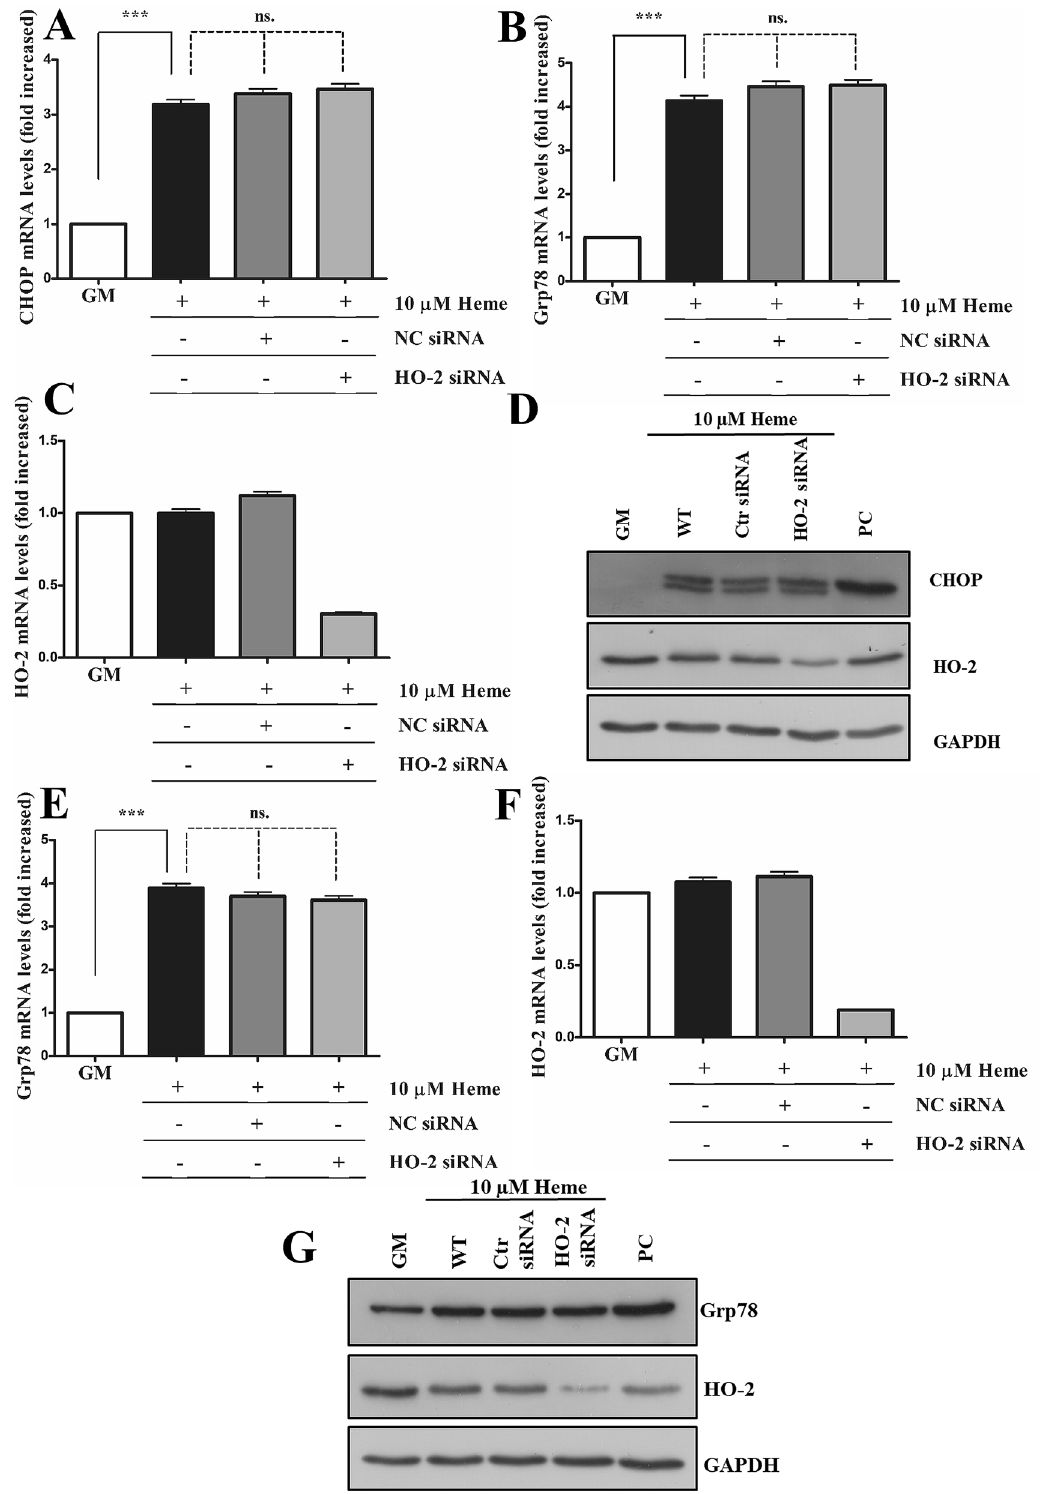
Figure 8. Knocking down heme oxygenase-2 (HO-2) does not aggravate HIER stress. HO-2 expression was knocked down with small interfering RNA, then ECs were exposed to heme (10 μM) for 2 h in serum- and antibiotics-free CM199. Then, the medium was changed to CM199 with 10% FCS and antibiotics. Relative expression of ( A ) CHOP, ( B ) Grp78, and ( C ) HO-2 mRNAs as well ( D ) CHOP and HO-2 protein levels were analyzed 3 h after the heme treatment. In another set of experiments, relative expression of ( E ) Grp78 and ( F ) HO-2 mRNA and ( G ) protein levels were analyzed 16 h after the heme treatment. GM growth medium, NC non-coding siRNA, HA heme arginate, PC positive control. Relative mRNA expressions were normalized to GAPDH. GAPDH was used as a loading control in immunoblots. Immunoblots are cropped from different parts of the same gel. Uncropped immunoblots are presented in the Supplementary information. Data are shown as mean ± SEM of three independent experiments. Statistical analysis was performed by one-way ANOVA test followed by Bonferroni correction. A value of p < 0.05 was considered significant. *** p <